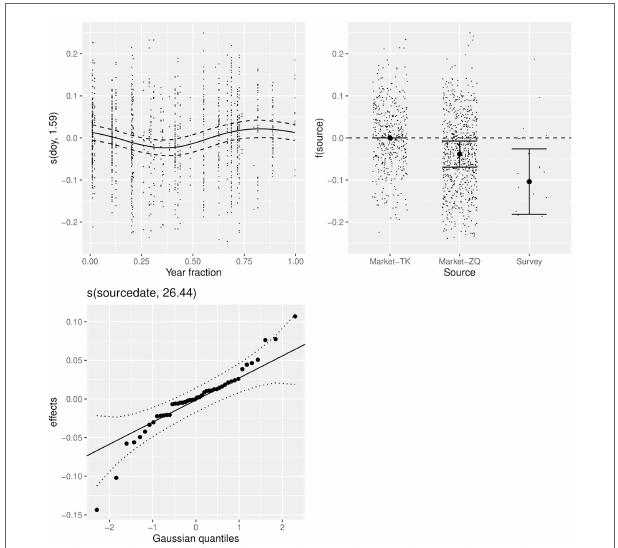
FIGURE 4 | Sex-dependent patterns in the relationship between log(fork length) and log(weight) of lizardfish, including trends for females (top left) and males (top right), mean differences between females and males (bottom left) and length-dependent differences (bottom